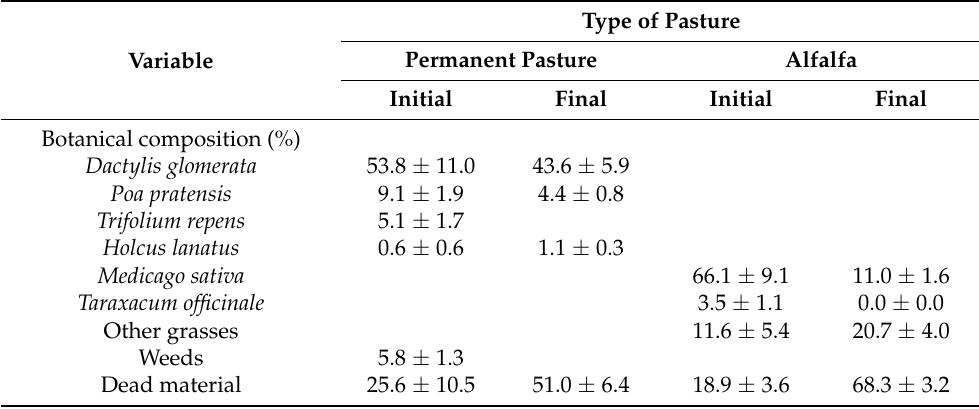
Table 2. Botanical composition and chemical characteristics of the pasture consumed in the experi- ment at the start and end of the grazing